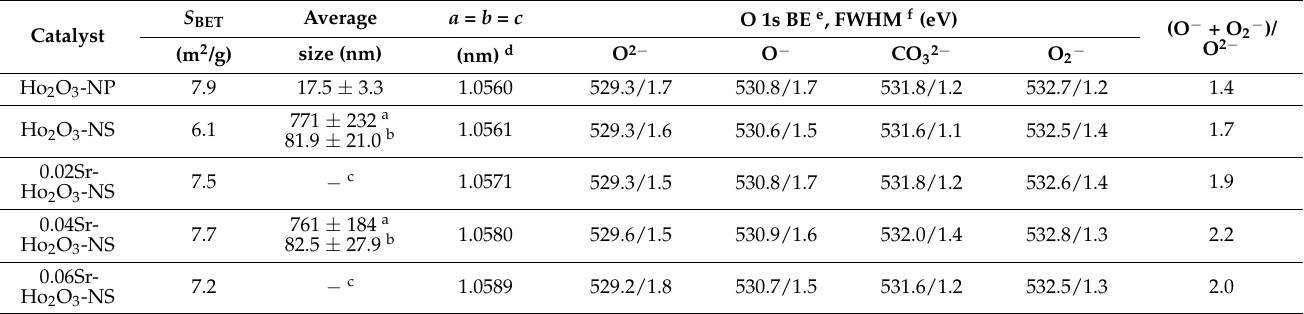
Table 2. Textural properties and XPS data of the Ho 2 O 3 -based